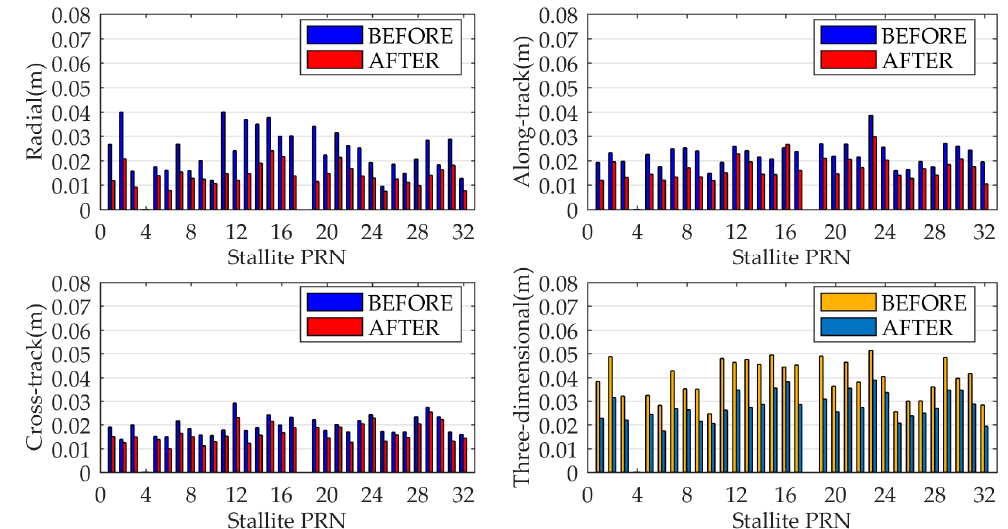
Figure 4. Seven-day average-RMS errors of all available GPS satellites in radial, along/cross-track, and three-dimensional (3D) directions.